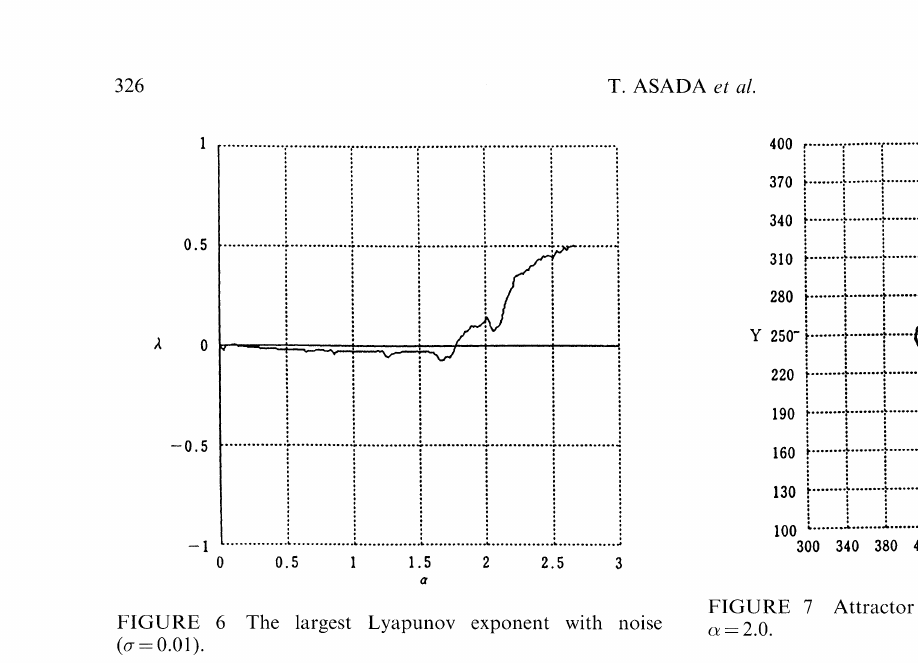
FIGURE 6 The largest Lyapunov exponent with noise (=0.01).